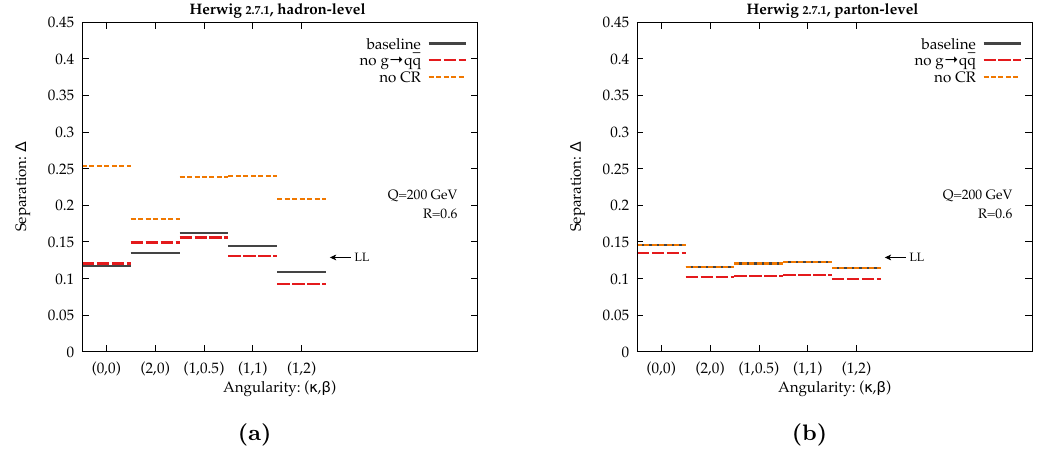
Figure 10. Same as (cid:12)gure 9, but for Herwig 2.7.1